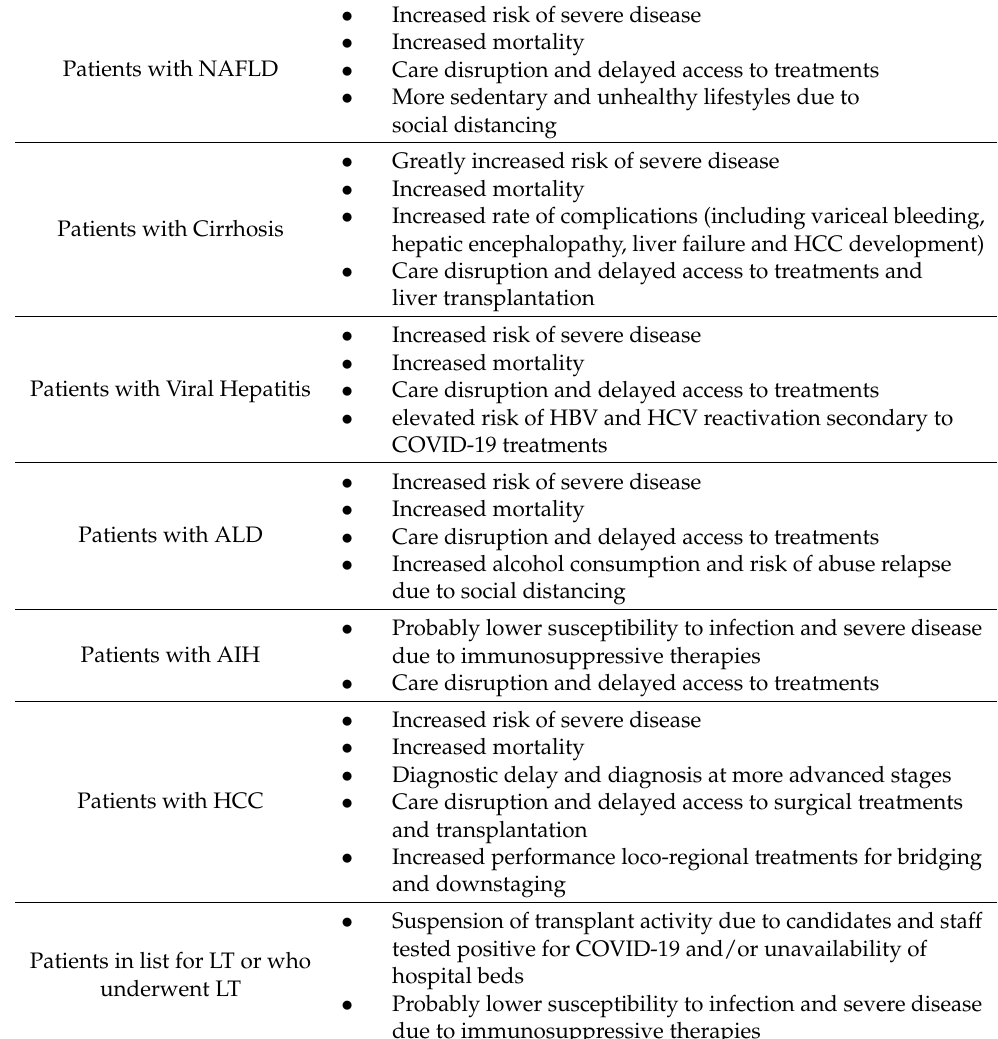
Table 1. Effects of COVID-19 infection in patients with pre-existing liver